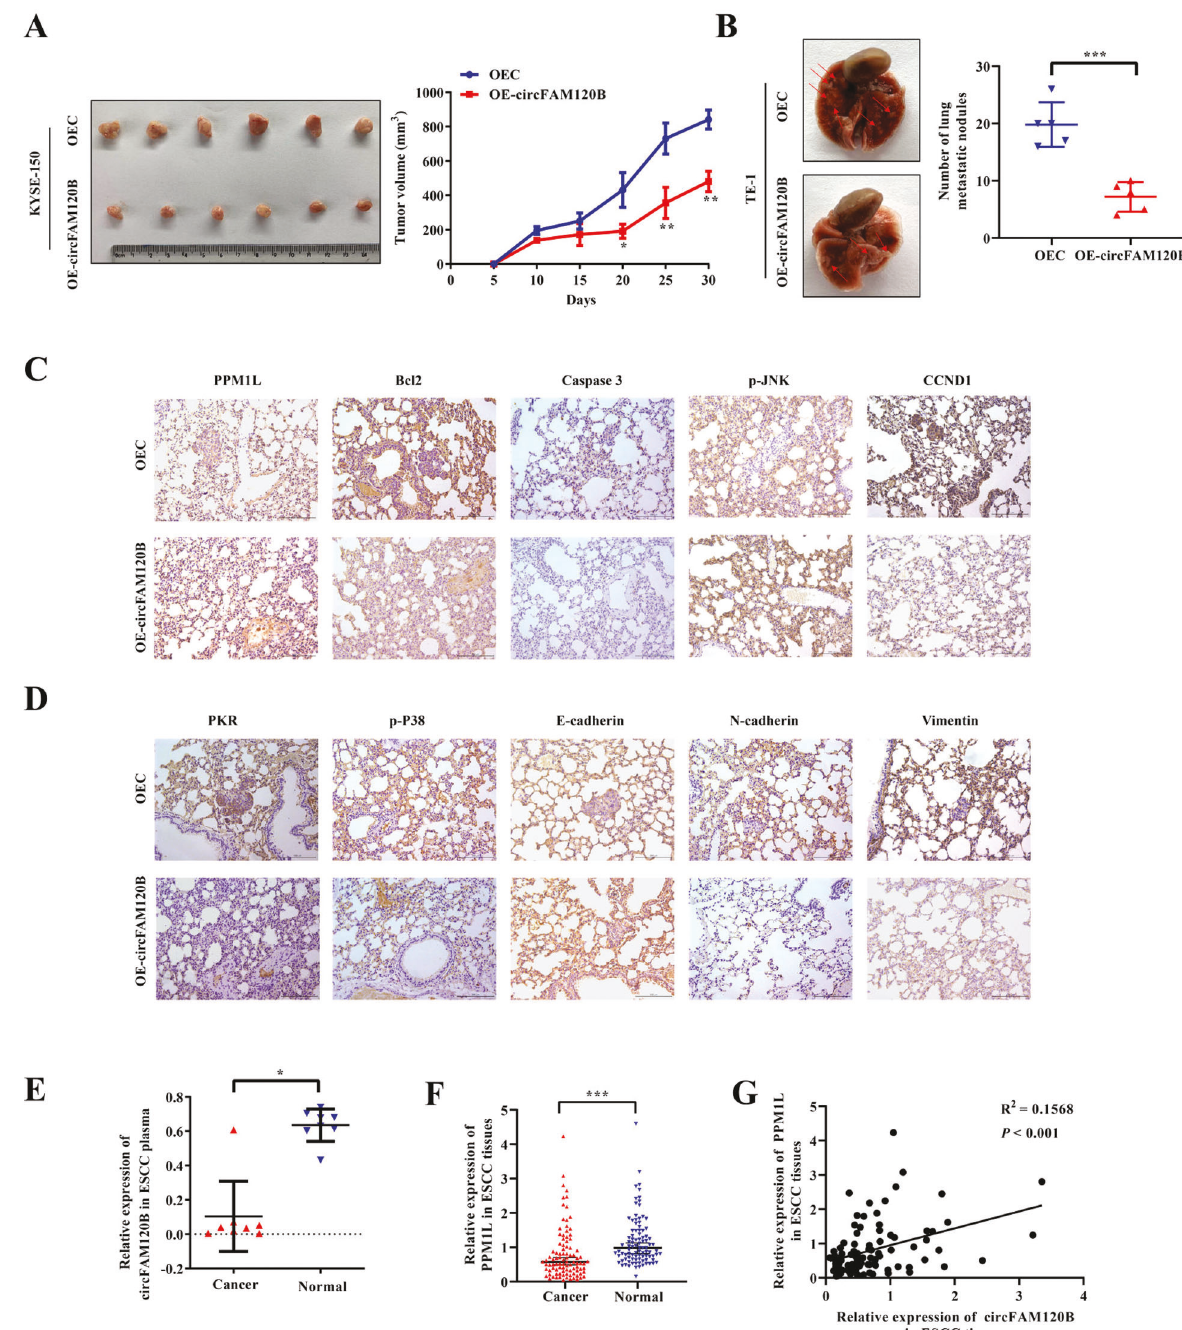
Fig. 6 circFAM120B depresses the tumorigenicity of ESCC in vivo and is associated with PPM1L in clinical samples. A KYSE-150 cells with indicated modi fi cations were subcutaneously injected into the fl anks of mice in the armpit. Subcutaneous xenograft tumors, as well as changes in tumor size, are displayed. B TE-1 cells with indicated modi fi cations were subcutaneously injected from the tail vein of nude mice. The lung tissues of the mice were harvested, and the number of metastatic foci was counted. C , D Indicated proteins were detected by IHC assays in murine tissues. The representative images are presented. E Detection of circFAM120B expression in eight pairs of plasma samples from ESCC patients and healthy volunteers by qRT-PCR analysis. F Assessment of PPM1L expression in 96 pairs of ESCC tissues by qRT-PCR analysis. G Correlation between circFAM120B and PPM1L expression in 96 pairs of ESCC